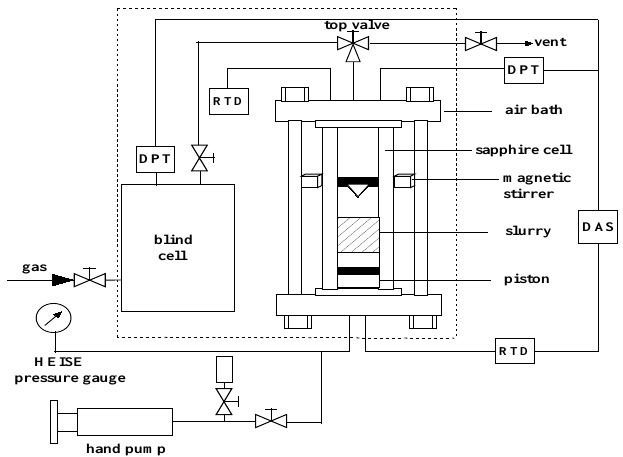
Figure 1. Schematic diagram of the experimental apparatus used for separation performance measurements: RTD, resistance thermocouple detector; DPT, differential pressure transducer; and DAS, data acquisition system.